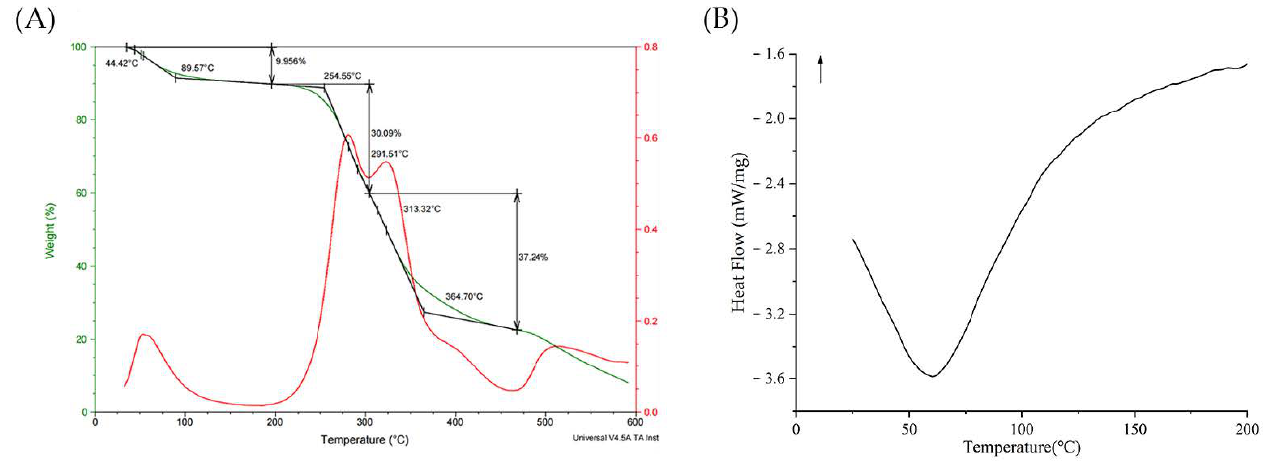
Figure 9. The thermogram curves of BCP. ( A ) TGA; ( B ) DSC.